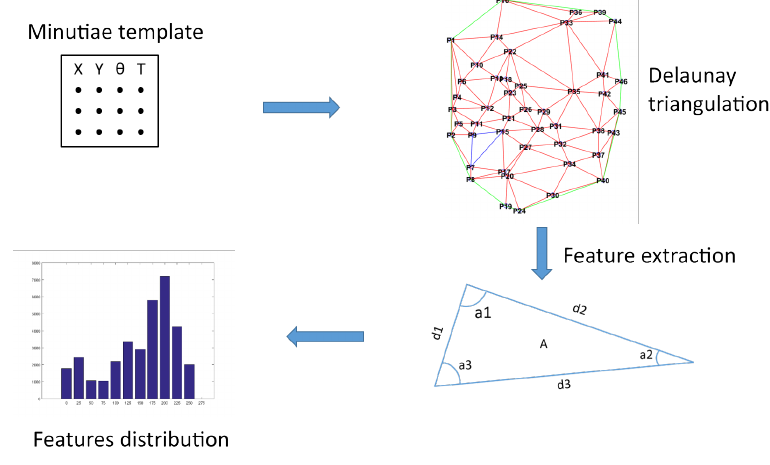
Figure 7. Features computation from the Delaunay triangulation (source